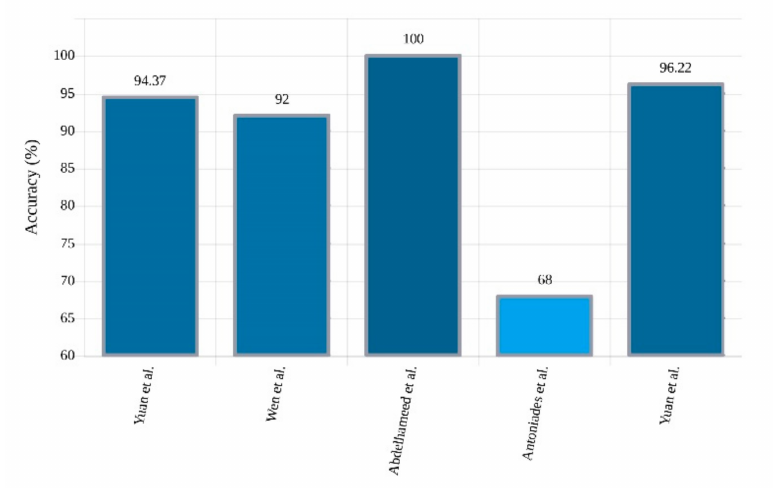
Figure 15. Sketch of accuracy (%) versus authors obtained using CNN-AE models for seizure